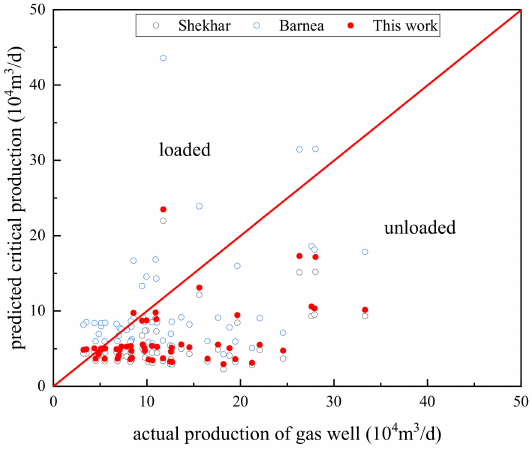
Figure 14. Comparison of prediction results of each model (Turner unloaded well).